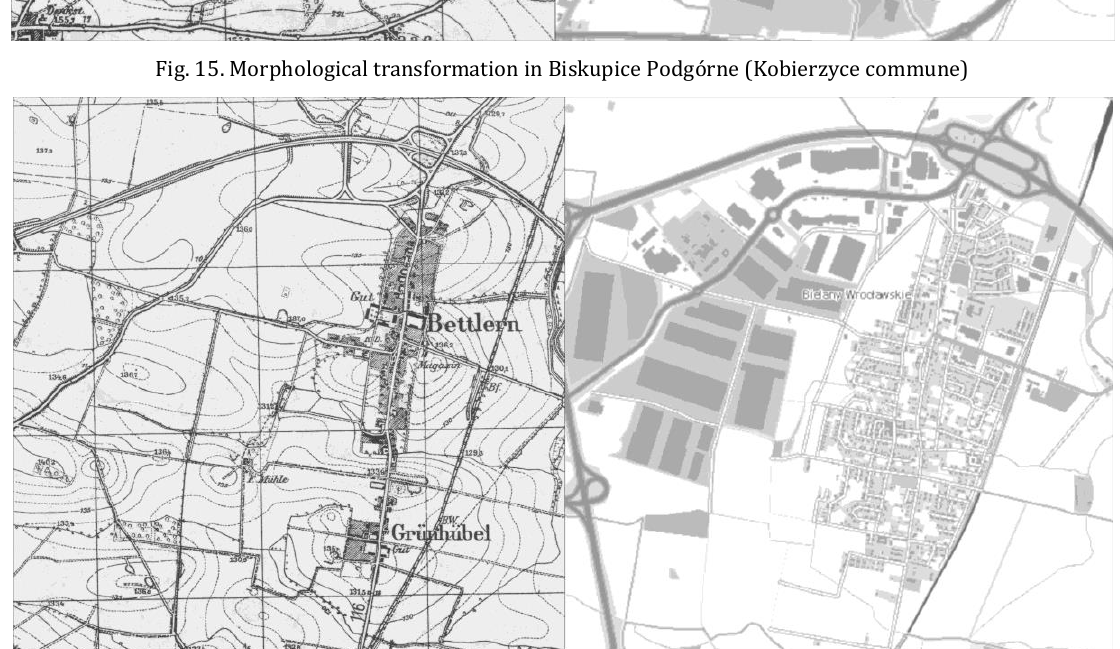
Fig. 15. Morphological transformation in Biskupice Podgórne (Kobierzyce commune)